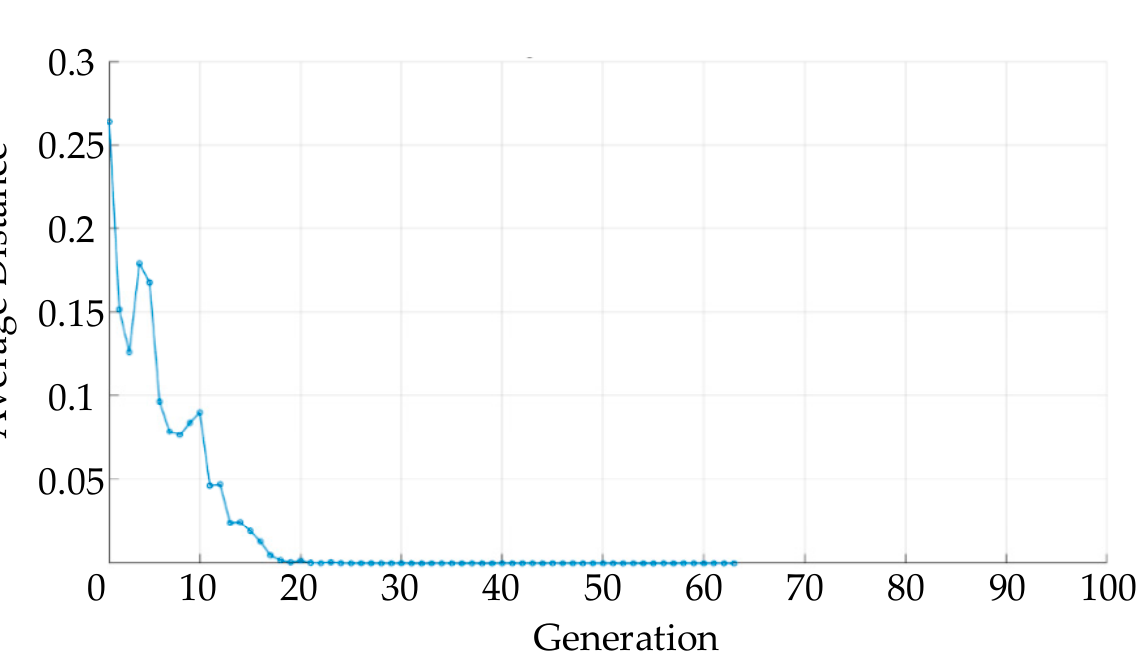
Table 2. Parameters of axial